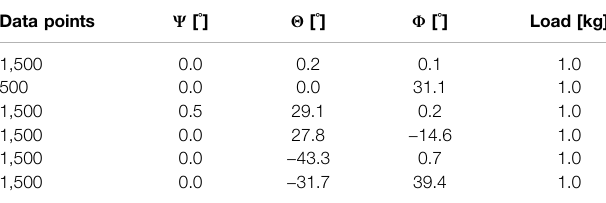
TABLE 2 | Base orientations of directional generalization dataset gen , dir